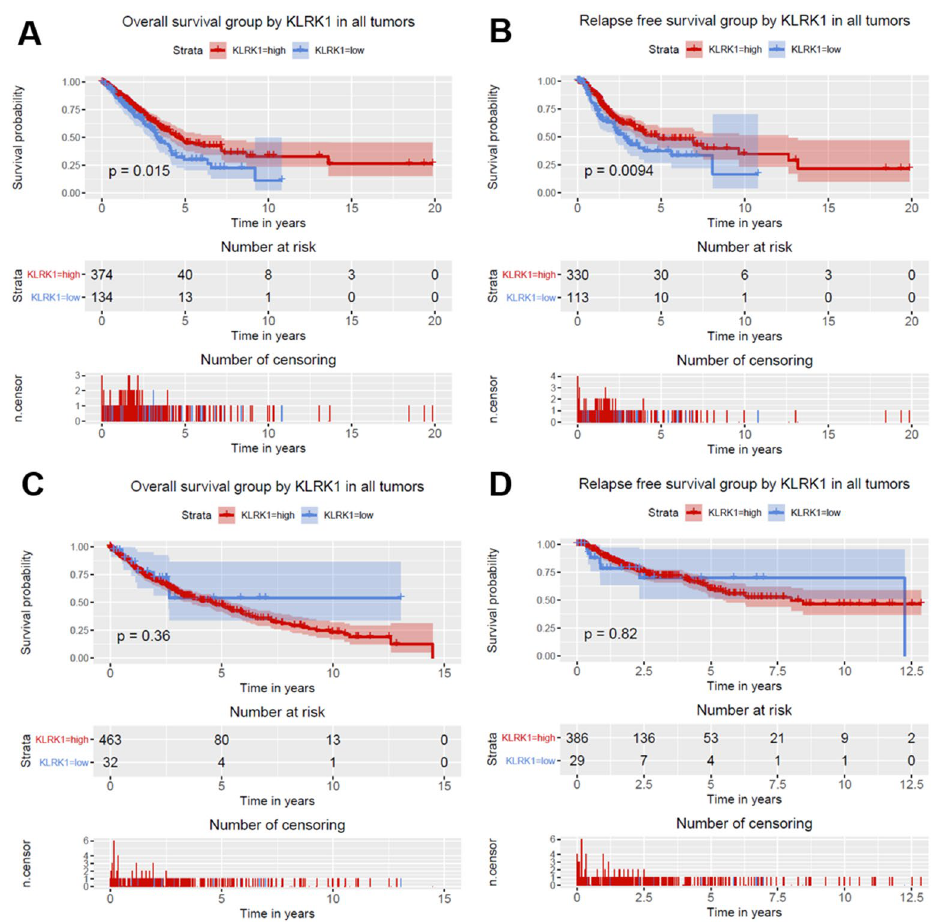
Figure 6. Relationship of KLRK1 expression with ( A ) overall and ( B ) relapse free survival in patients with lung adenocarcinoma cancer, and ( C ) overall and ( D ) relapse free survival in patients with lung squamous cell